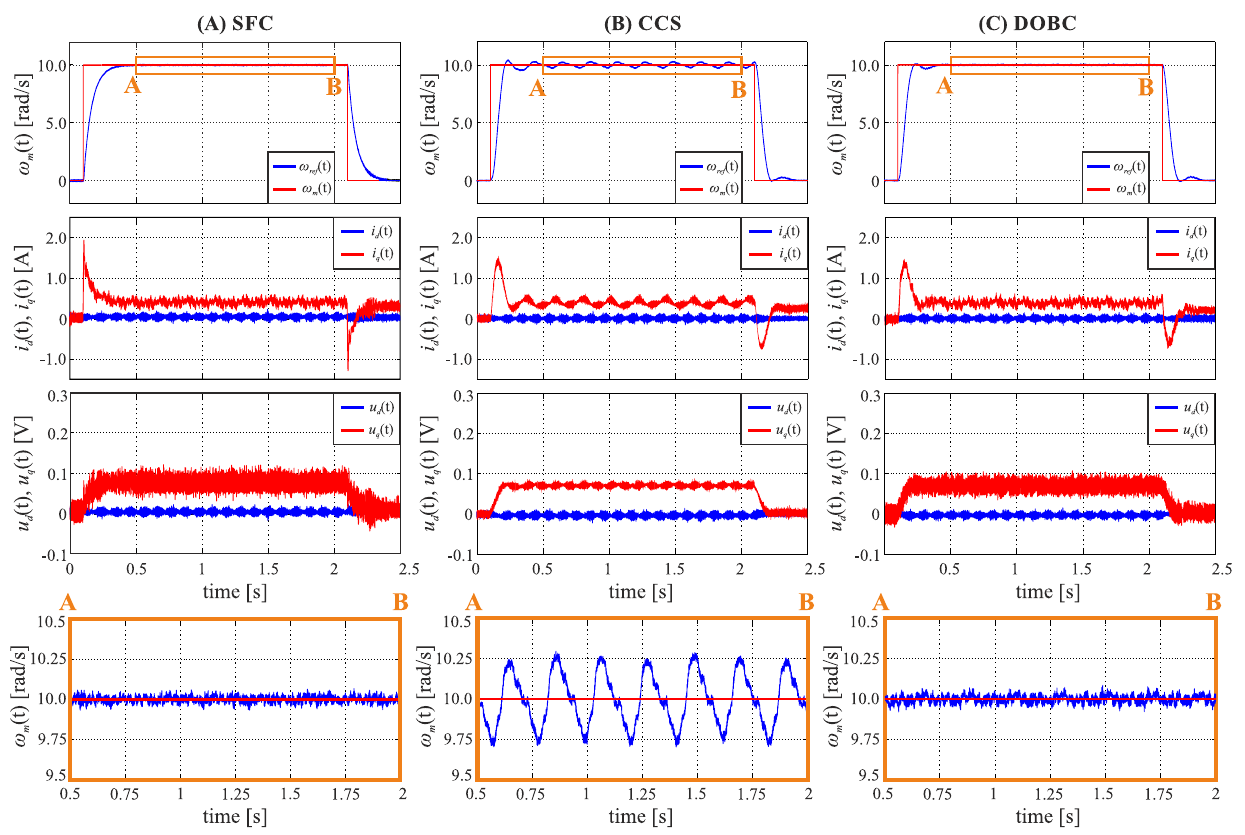
Figure 7. Step response of investigated control structures for reference signal of 10 rad/s without load: ( A ) state feedback controller, ( B ) PI based cascade control structure, ( C ) PI based cascade control structure with the disturbance observer.